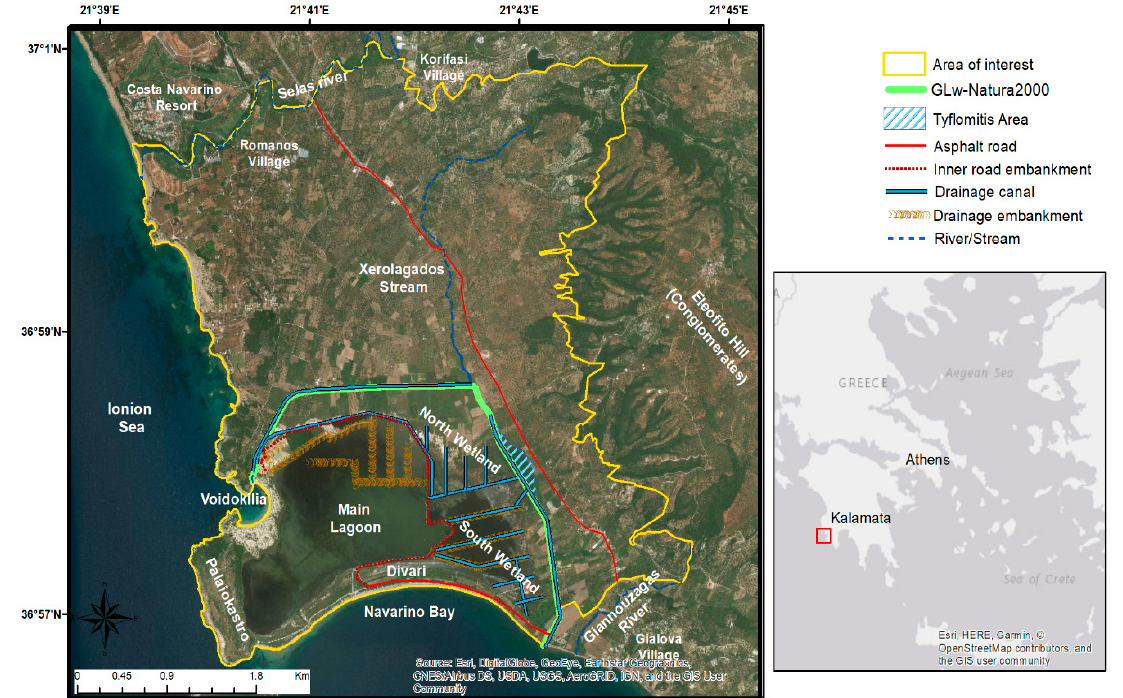
Figure 1. Map of the study area, including the Gialova Lagoon (GL) and surrounding wetlands in the Natura 2000 site (green line), and the wider area of interest encompassing the catchments draining into GL (yellow line).